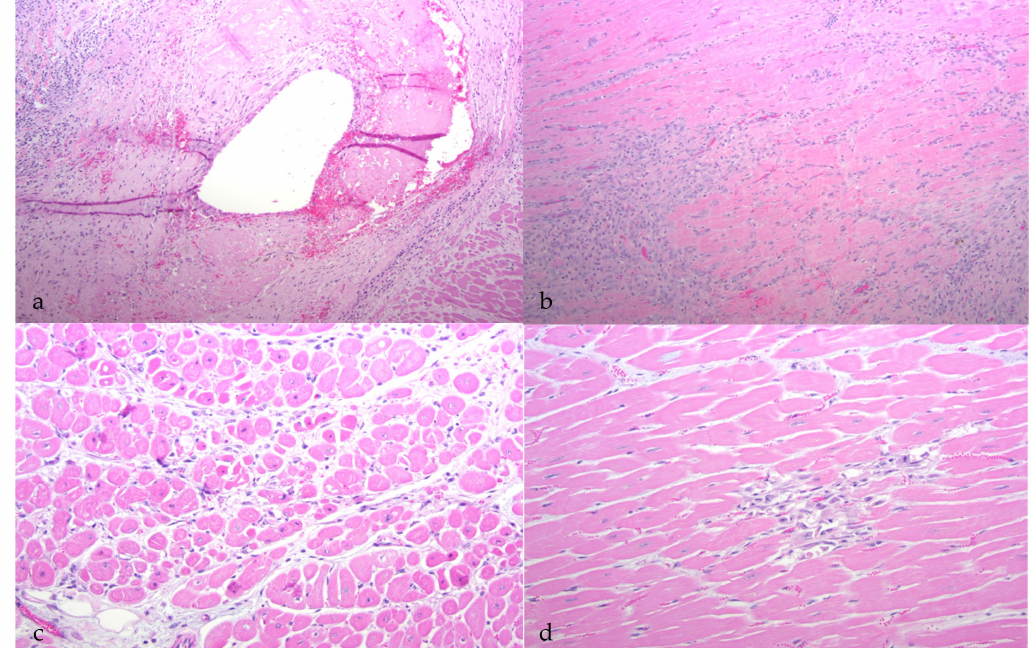
Figure 3. Histological features of CAEV-associated cardiac lesions (HE-stained sections). ( a ) A large artery within the myocardium has luminal and mural fibrin deposition and periarteriolar inflammation (thrombotic arteritis, goat A). ( b ) The myocardium has interstitial fibroplasia/fibrosis and lymphocytic inflammation (fibrosing myocarditis, goat C). ( c ) Cardiomyocytes are multifocally atrophied and have pyknotic nuclei (myocardial necrosis, goat D). ( d ) The myocardial interstitium has a focal loss of cardiomyocytes with interstitial fibroplasia (goat